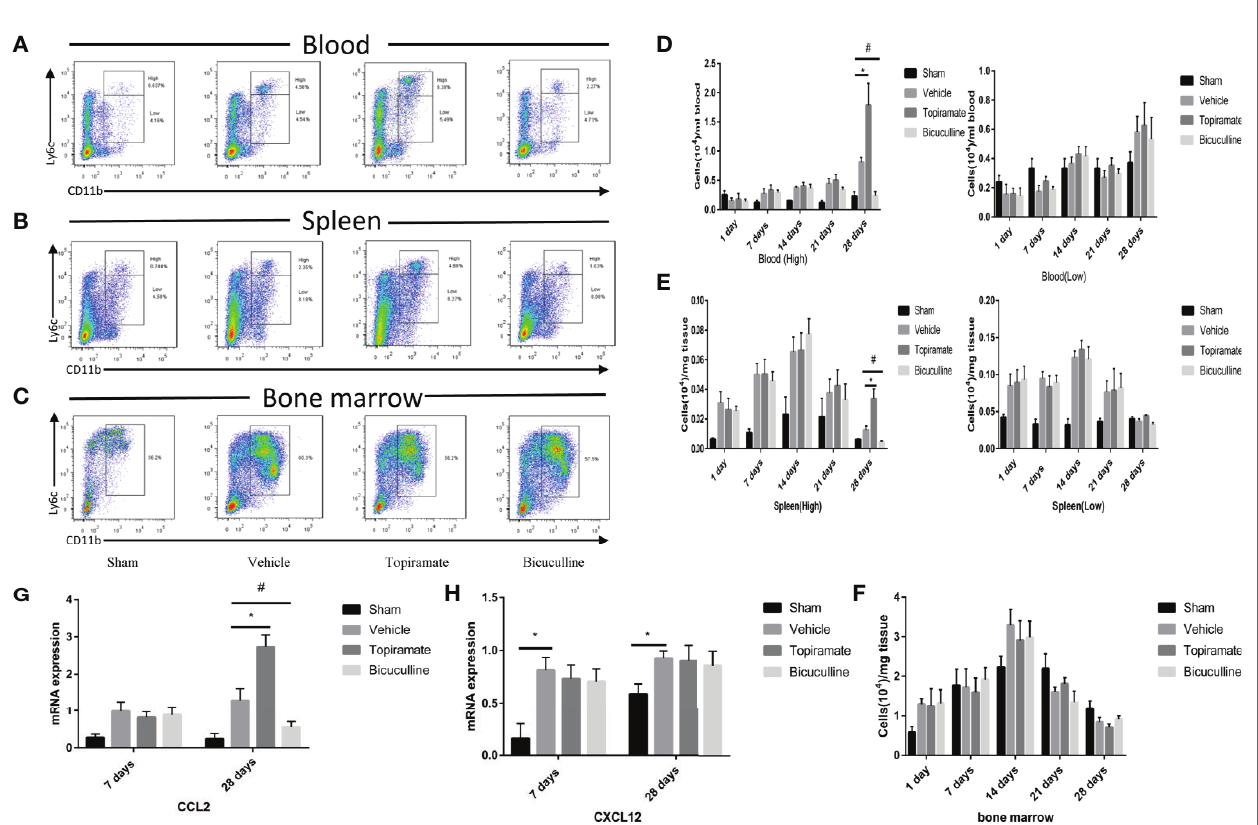
FIGURE 4 | Activation or blockade of the GABA A receptor promotes or reduces monocyte recruitment in pressure-overload hypertrophy mice. (A, B) Representative images for fl ow cytometric analysis of CD45 + Ly6G - CD11b + Ly6C high and CD45 + Ly6G - CD11b + Ly6C low monocytes in the blood (A) , and spleen (B) at day 28 post-TAC. (C) Representative images for fl ow cytometric analysis of monocytes (CD45 + Ly6G - CD11b + Ly6C + ) in bone marrow at day 28 post-TAC. The representative images of other time points are shown in supplementary materials. (D) The number of Ly6C high or Ly6C low monocytes (per ml blood) among the total number of live cells isolated from blood at the indicated time points. (E) The number of Ly6C high or Ly6C low monocytes (per mg spleen) among the total number of live cells isolated from spleen at the indicated time points. (F) The number of monocytes (per mg marrow bone) among the total number of live cells isolated from marrow bone at the indicated time points. (G, H) Expression of Ccl2 and Cxcl12 marker genes at days 7 and 28 post-TAC. Data show the mean ± SEM, by one-way ANOVA with Bonferroni ’ s multiple comparison test. For topiramate treatment, *P < 0.05 vs. vehicle. For bicuculline treatment, # P < 0.05 vs. vehicle. (n = 3 mice for sham group, n = 6 – 8 mice for all other